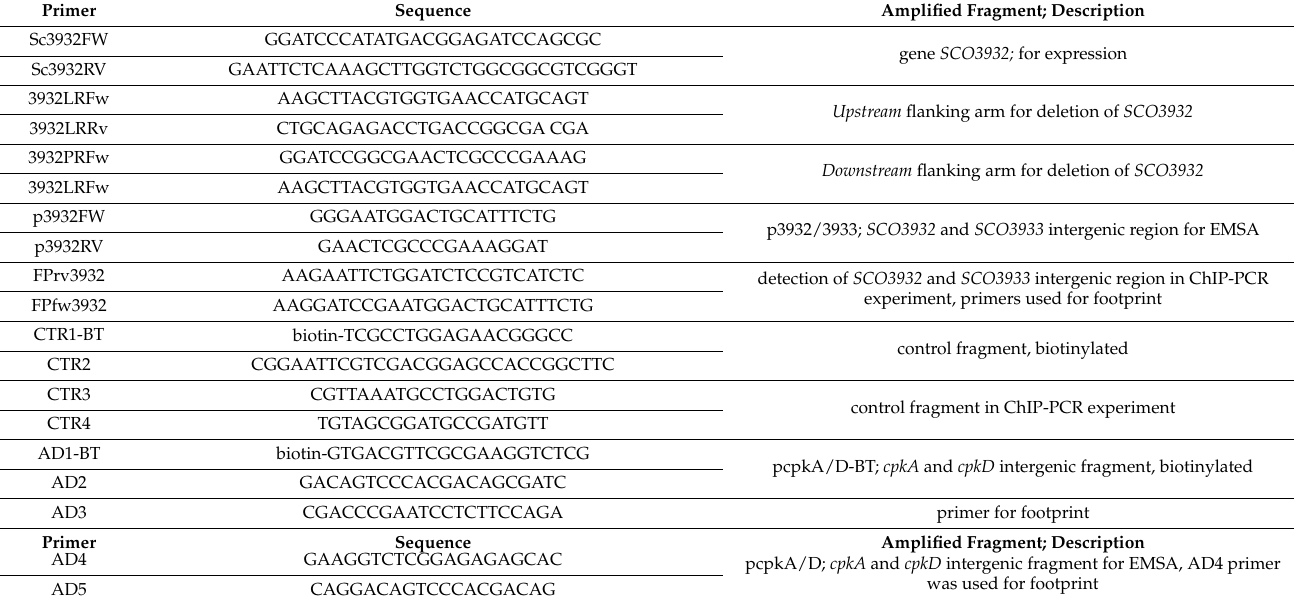
Table 2. Oligonucleotides used in this work. Gene numbers according to Bentley et al. 2002 [5]. Restriction sites are in bold.